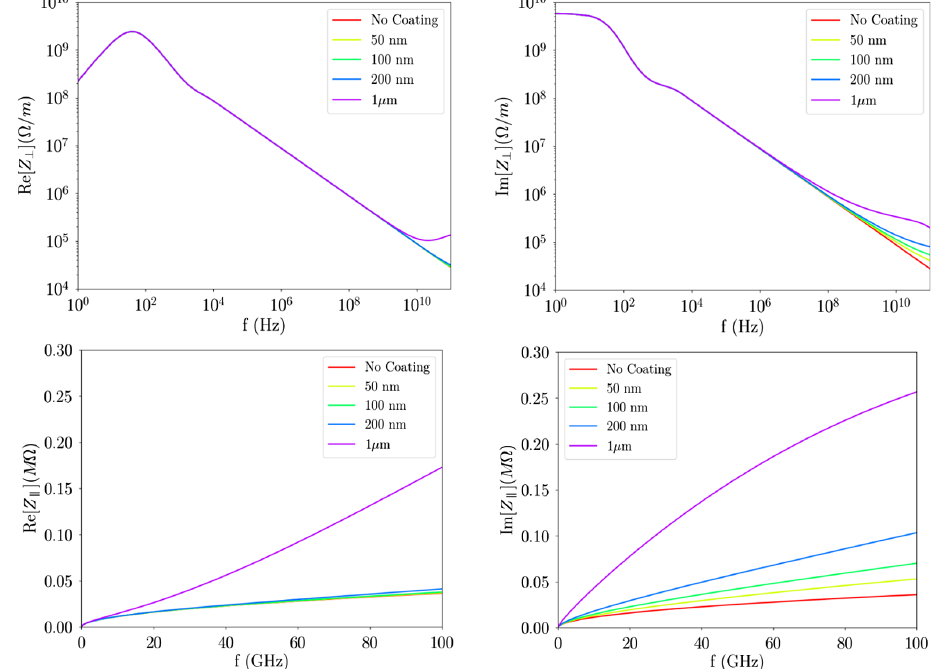
FIG. 3. Real and imaginary part of transverse (top) and longitudinal (bottom) RW impedances as a function of the frequency in the case of no coating, with a copper pipe of 35 mm of radius, and with different thicknesses of coating B.